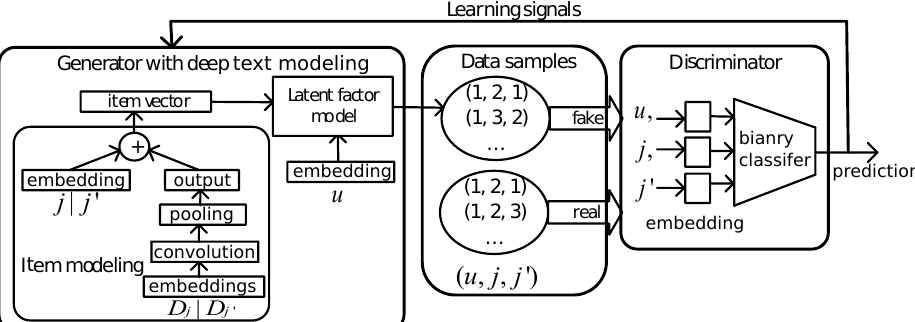
Figure 1. Illustration of Adversarial Deep Hybrid Recommendation (ADHR) model. ADHR consists of two components: a generator and a discriminator. The generator is a deep hybrid model to capture the pairwise ranking distribution where a convolutional neural network is used to extract high-level item content features. The discriminator is a binary classifier based upon latent factor model, which takes the user and item embeddings in a sample pair as input and predicts the probability of the sample being real. While the generator provides fake samples for training the discriminator, the discriminator provides learning signals that drive the optimization of the